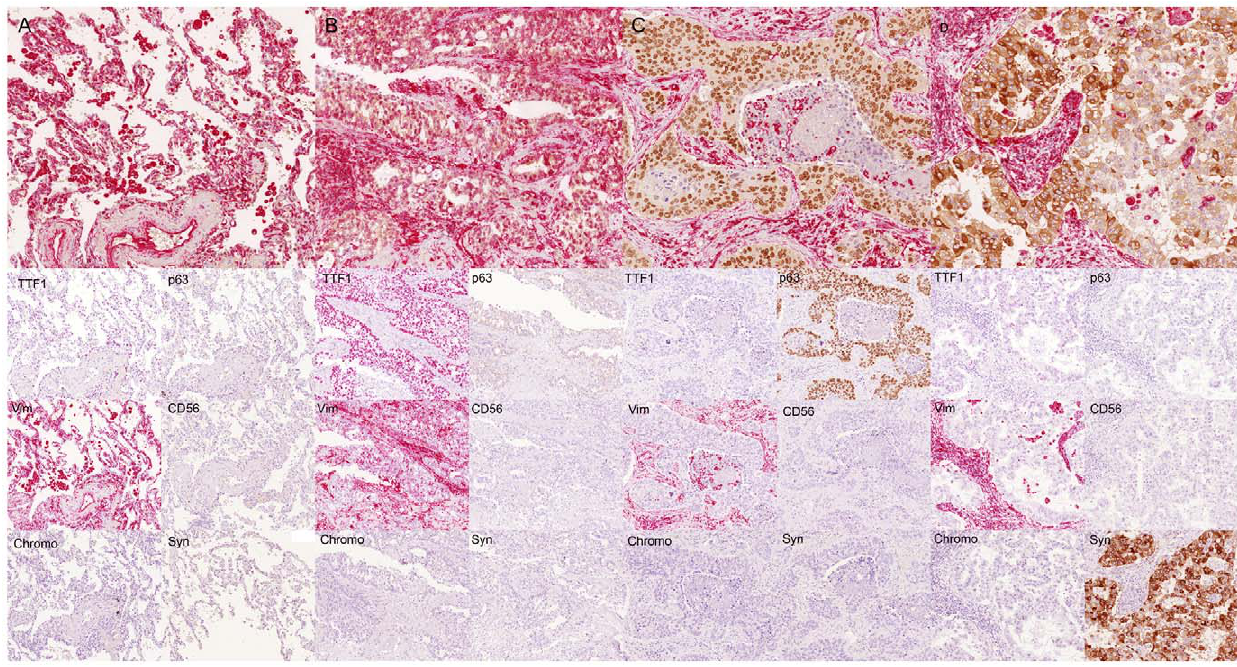
Figure 2. Immunohistological images obtained from multi-antibody assay compared to single antibody stains. Normal lung tissue (A), LAC (B), SCC (C) and LCNEC (D) stained with the combined multi-antibody assay (top) and each single included antibody. Red nuclei – TTF1; red cytoplasm – vimentin; brown nuclei – p63; brown cytoplasm – neuroendocrine markers. Below the bi-color IHC assay corresponding single antibody assays are displayed in the same tumor area. Comparison of each single antibody staining and the bi-color multi antibody assay shows analog specific positivity in the same cells and does not reveal any unspecific background staining or chromogenic cross reactivity.